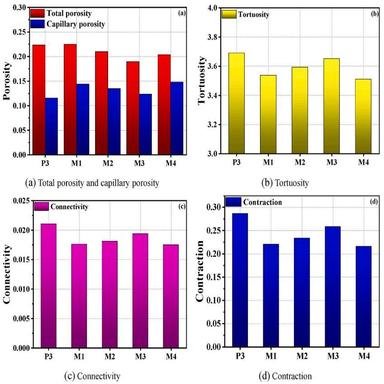
Illustrates the pore structure characteristic parameters of the samples.